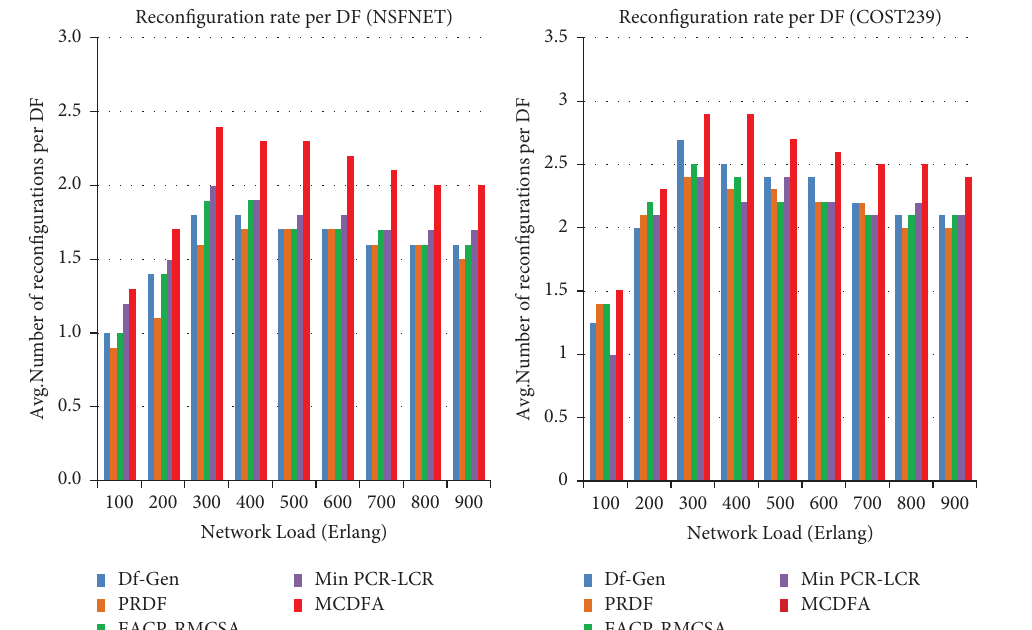
Figure 13: Te average number of reconfgured connections performed DF in (NSFNET) and